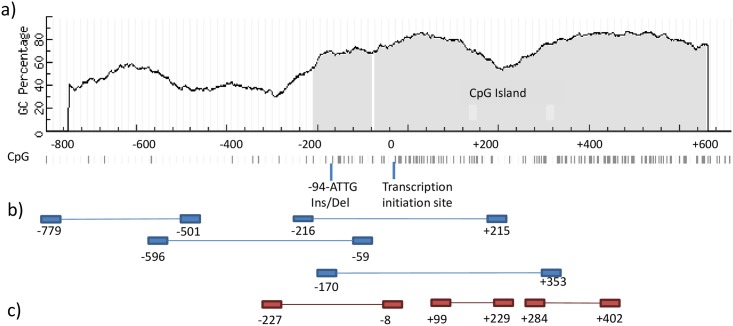
Graphic view showing primers and sequence features such as GC percent, CpG islands, and CpG site derived from MethPrimer [10] nucleotide numbers base on transcription initiation site [16] a) graphic view of the NFKB1 Promoter sequence from nt-800 to nt+600; CpG dinucleotides are indicated as bars b) graphical view of primers utilized for CHART-PCR, c) graphical view of primers utilized for methylation specific PCR.